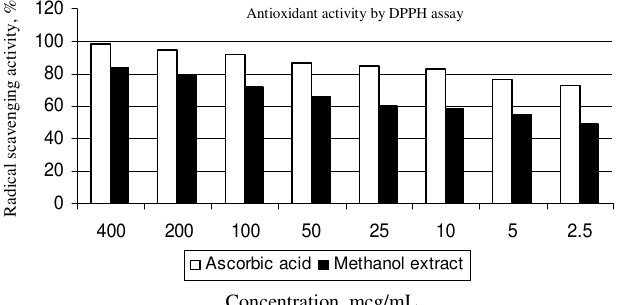
Figure 2. DPPH radical scavenging activity of methanol extract of E. cirrhatum